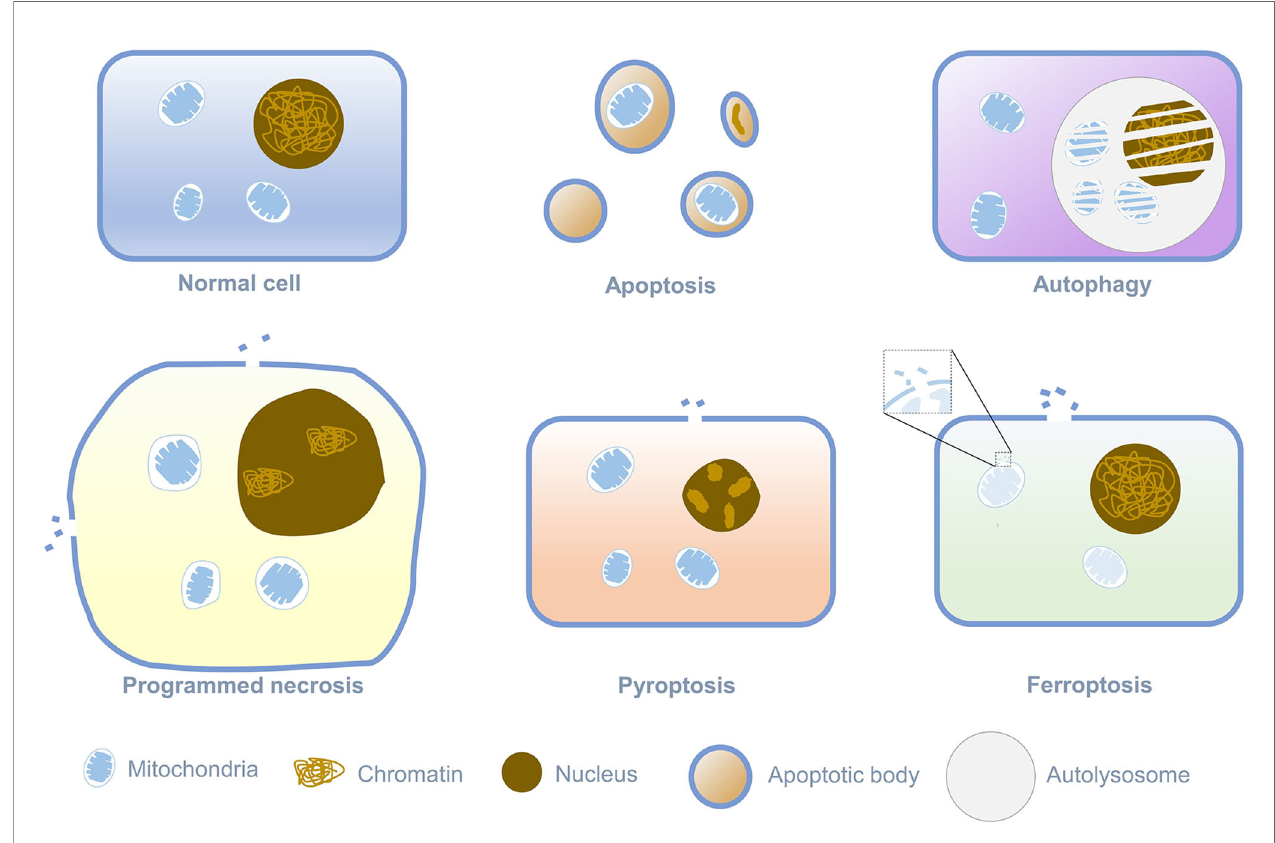
FIGURE 1 | Morphological Features of different programmed cell